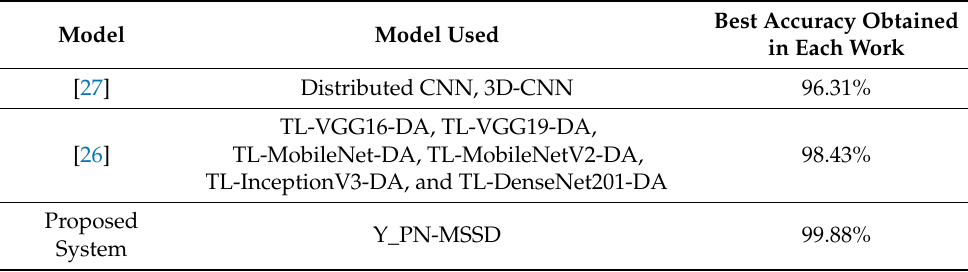
Table 5. Comparison of accuracy of proposed system and other works involving yoga posture recognition.